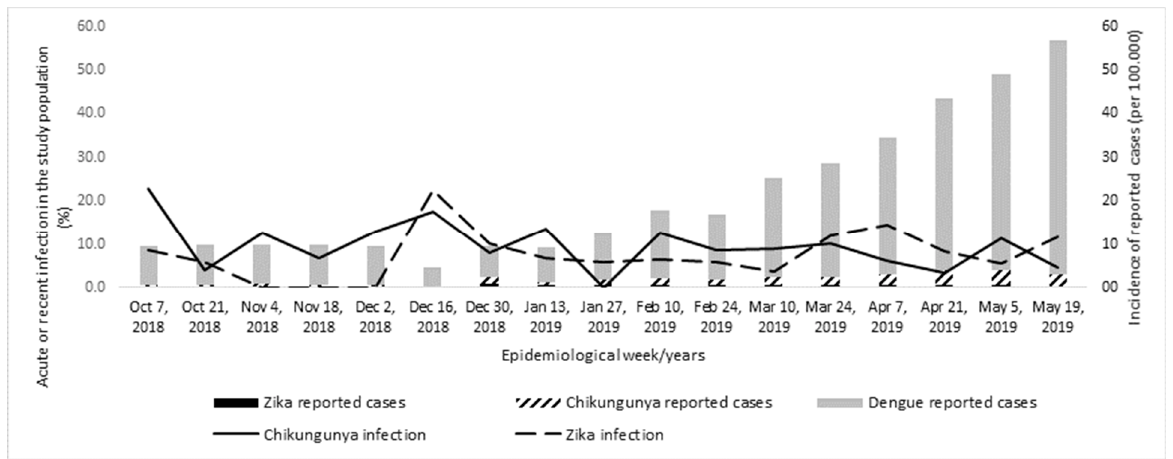
Figure 2. Temporal distribution of the ZIKV and CHIKV active or recent infection among screened pregnant women (lines) and incidence of arbovirus cases reported by the official surveillance system(bars) [26] from Recife, Pernambuco, October 2018 to May 2019.